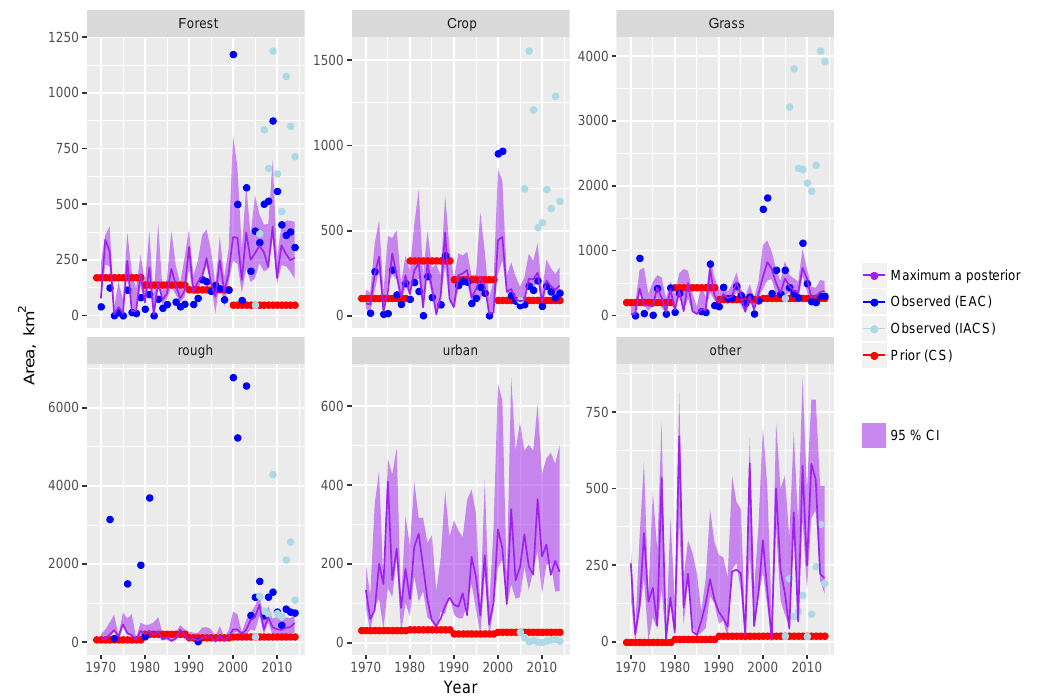
Figure 6. Time series of the gross gain in area of each land use ( A ut ) from 1969 to 2015, showing the observations, prior, and posterior estimates. The shaded band shows the 2.5 and 97.5% percentiles of the posterior distribution.